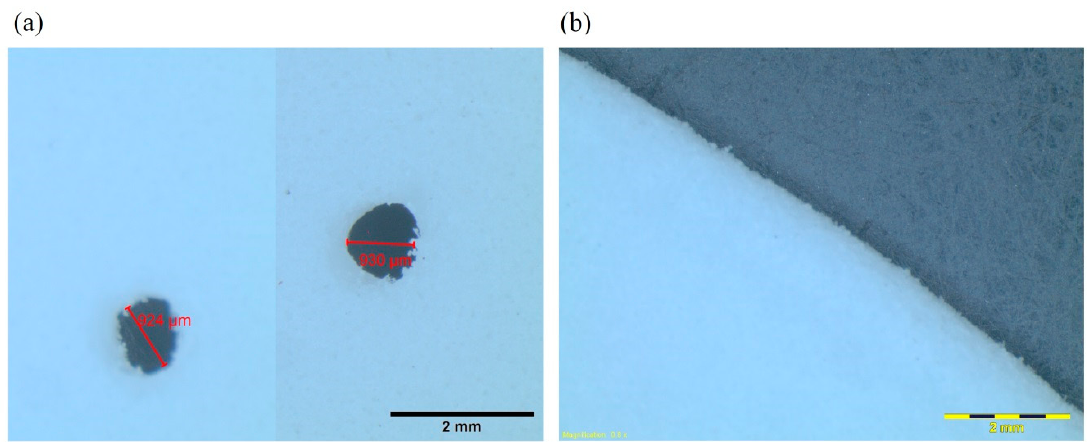
Figure 6. The microscope images of a printed panel: ( a ) two perforations in imperfect circular shapes and ( b ) a part of the unsmooth rim with grains.